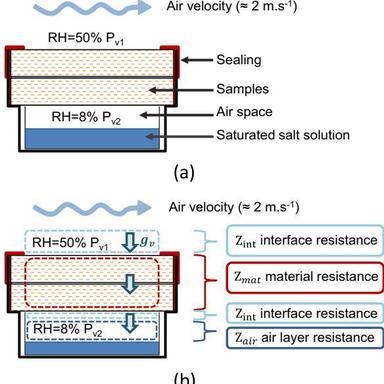
Scheme of the dry cup assembly for vapour permeability measurement (a) and the different water vapour resistance layers (b) (adapted from \).